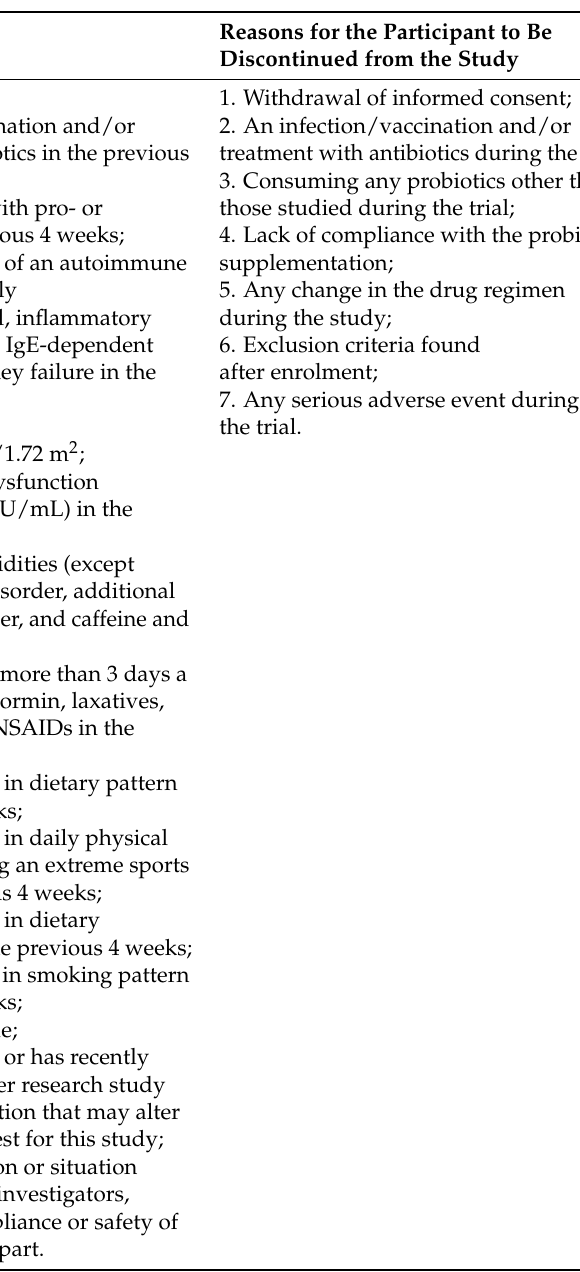
Table 3. Eligibility criteria. BMI: body mass index; GFR: glomerular filtration rate; ICD-11: Interna- tional Classification of Diseases 11th Revision; MADRS: Montgomery–Åsberg Depression Rating Scale; NSAIDs: nonsteroidal anti-inflammatory drugs; PPIs: proton-pump inhibitors; TASR: Tool of Assessment of Suicide Risk; TSH: thyroid stimulating